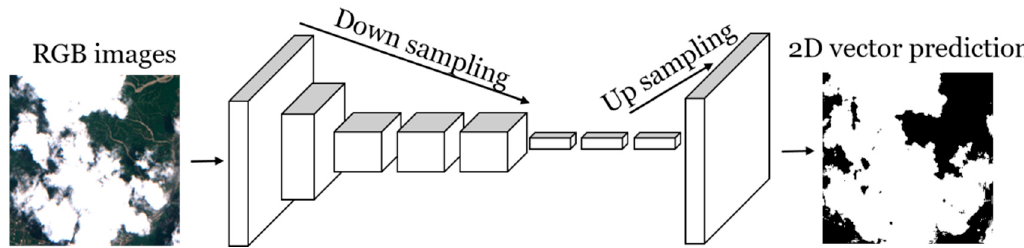
Figure 5. Illustration of fully convolutional neural network (FCN) architecture for cloud classification.